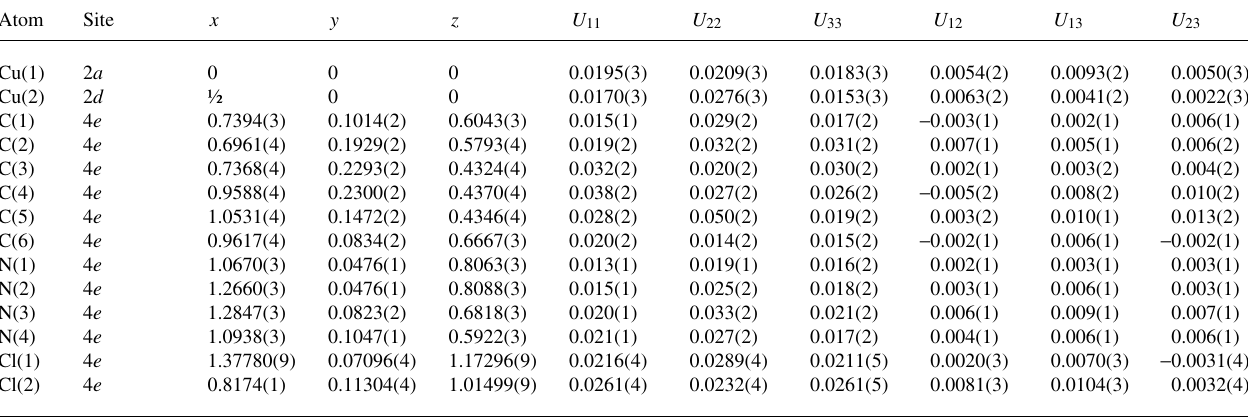
Table 3. Atomic coordinates and displacement parameters (in Å 2 )